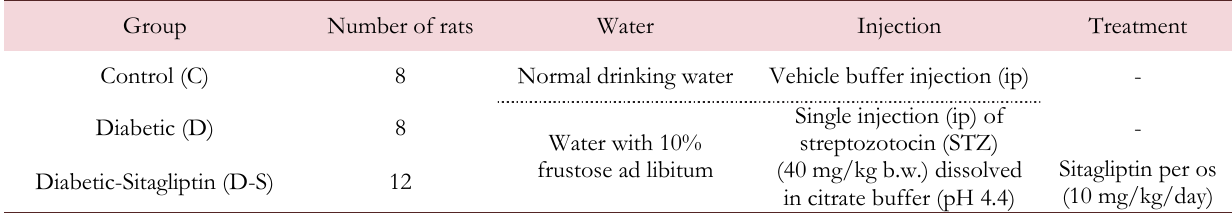
Table 1: The groups of animals tested and the treatment taken.